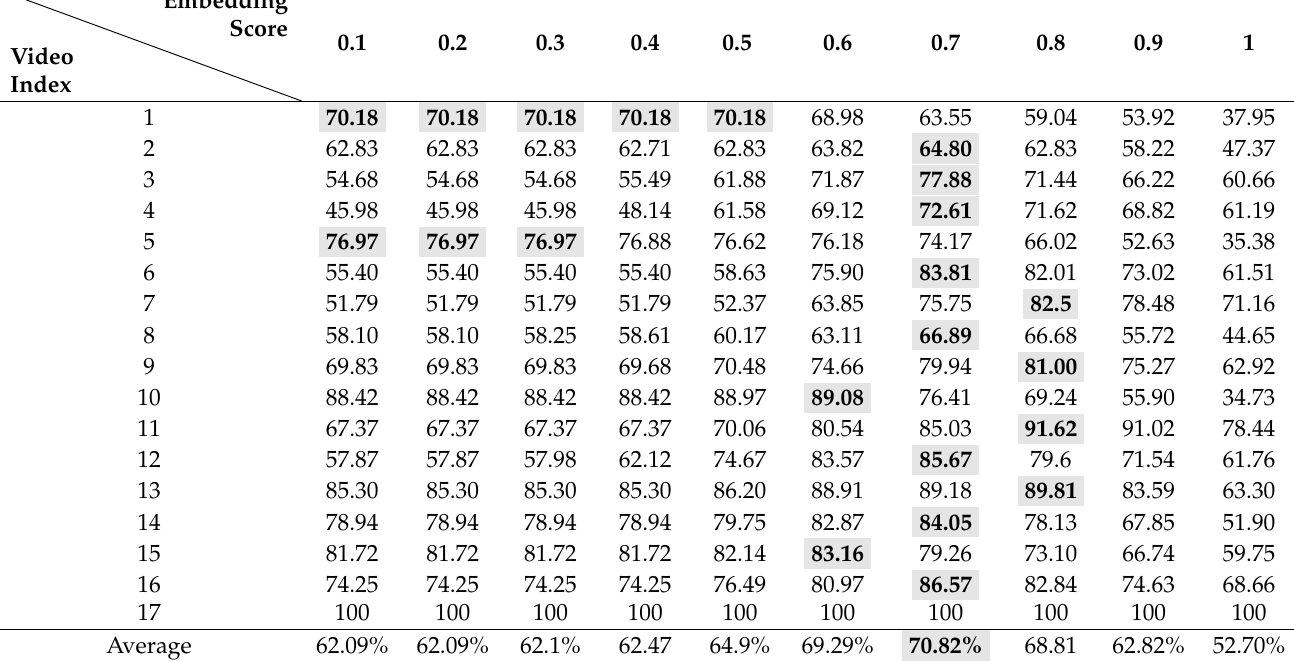
Table 9. Child face recognition rate (%) according to the range of embedding score values (bold text: The most recognition rate by video index according to the range of embedding